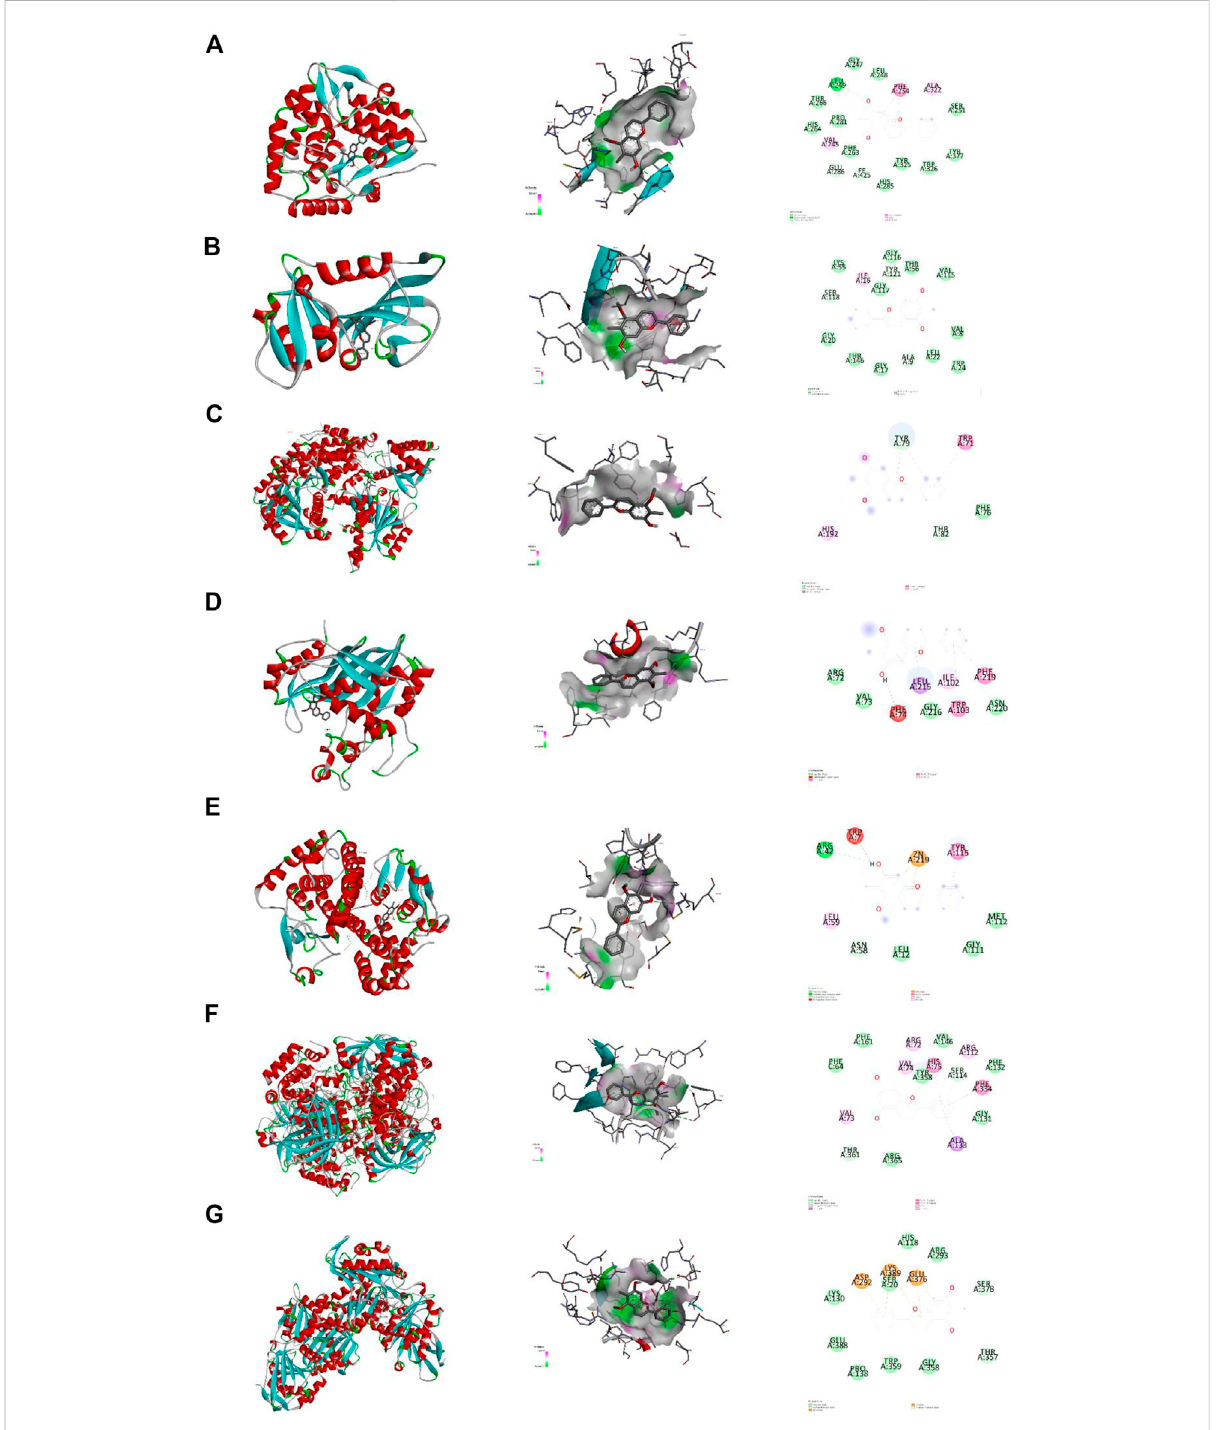
FIGURE 11 Molecular docking. Note. Binding mode of proteins and ligands. (A) Binding mode of GSTM1 with DP. (B) Binding mode of TYMS with DP. (C) Binding mode of PAH with DP. (D) Binding mode of DDC with DP. (E) Binding mode of DHFR with DP. (F) Binding mode of CAT with DP. (G) Binding mode of PGM1 with